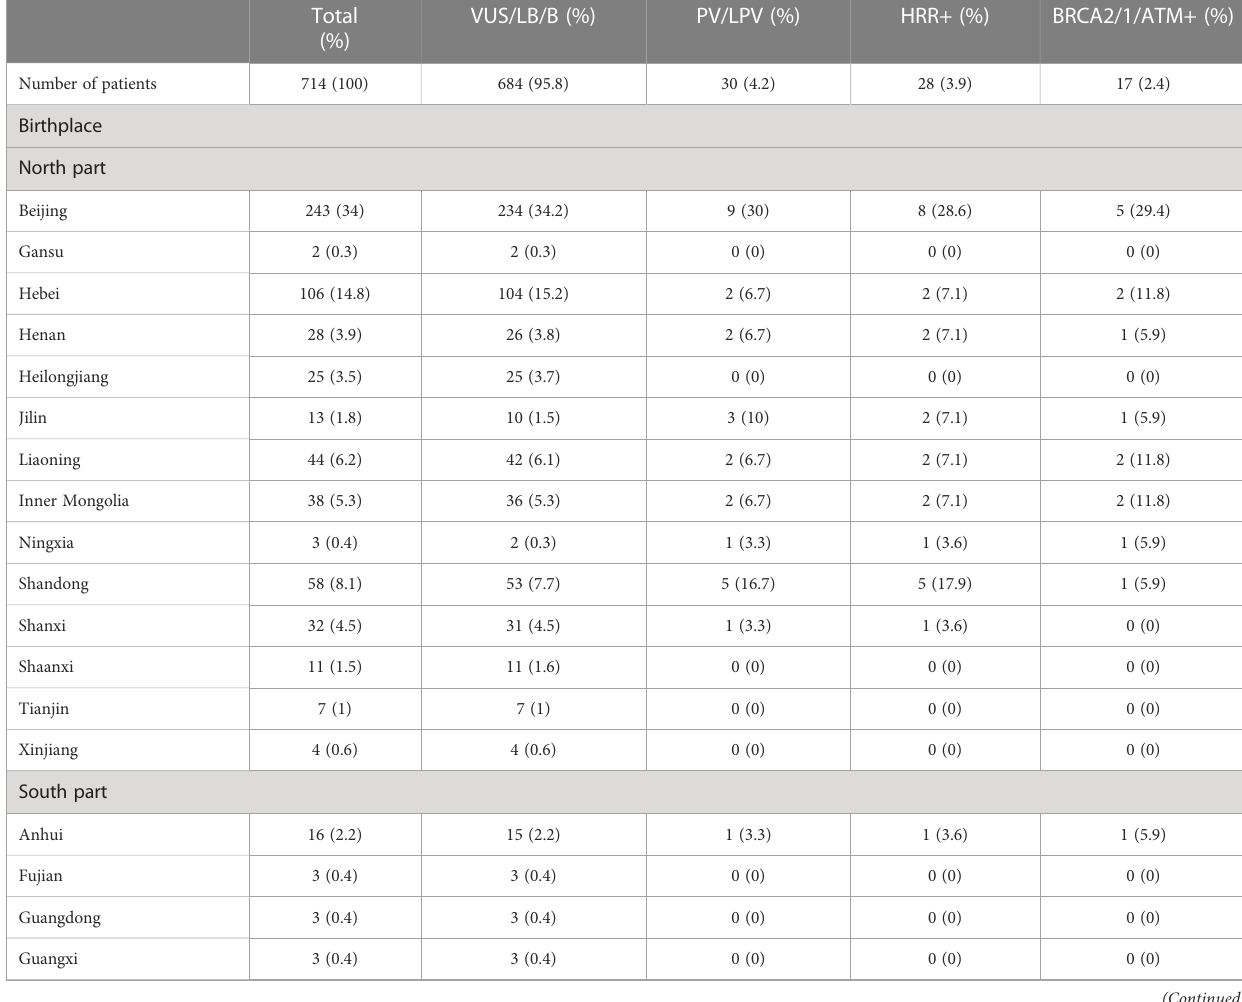
TABLE 2 Clinical characteristics of germline testing at